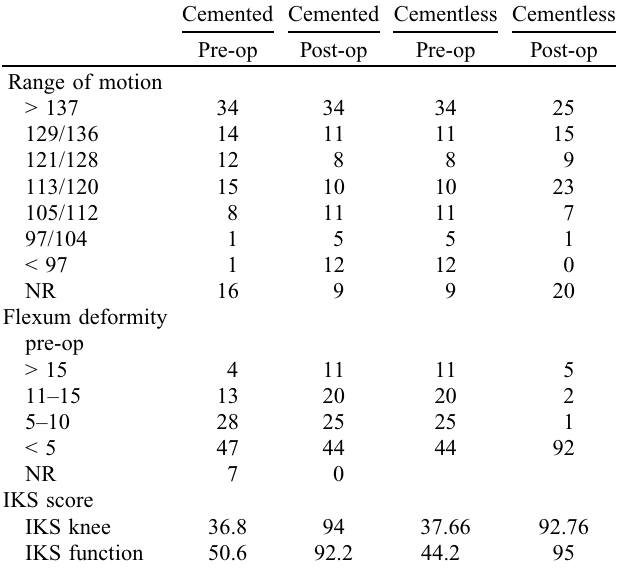
Table 2. Correlation of pre- and post-operative range of motion in cemented and cementless